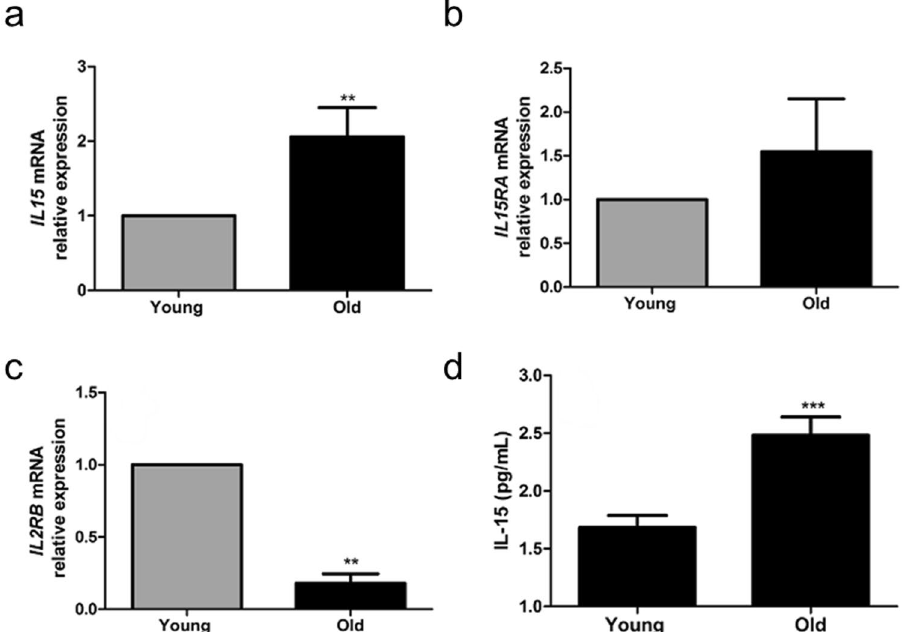
Figure 4. Elderly individuals display increased skeletal muscle IL-15 expression and increased plasma IL-15 concentrations. ( a , b , c ) IL15 , IL15RA and IL2RB gene expression were quantified in skeletal muscle tissue by RT- PCR. ** p < 0.01, vs. unstimulated condition by Mann-Whitney U test, N = 5. ( d ) Plasma IL-15 concentrations were assayed by ELISA. *** p < 0.001 vs. the unstimulated condition by t-test. Data expressed as mean ± SEM, N =